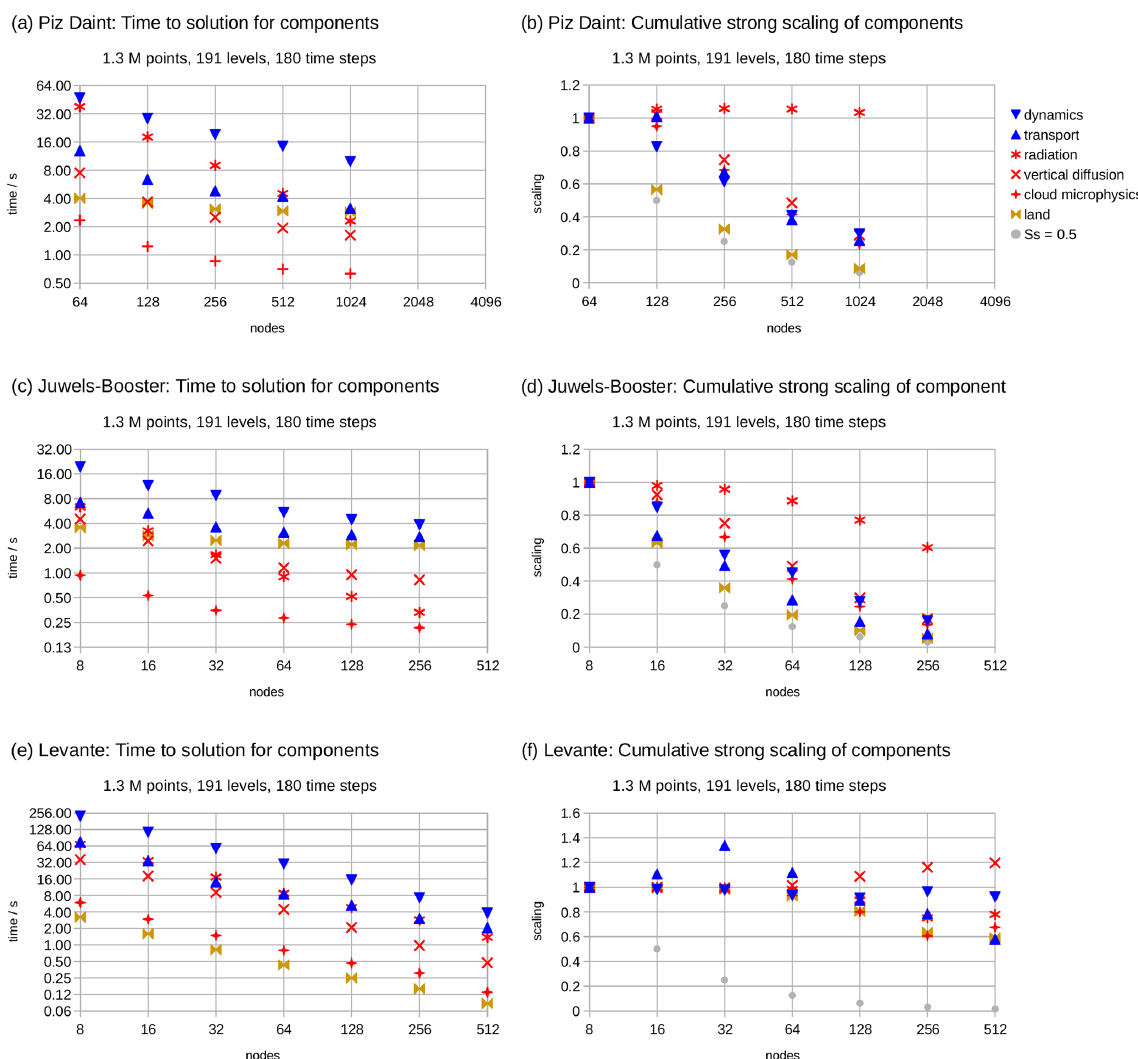
Figure 6. Time to solution (a, c, e) and cumulative strong scaling S s , cum (b, d, f) for Piz Daint (a, b) , JUWELS Booster (c, d) , and Levante (e, f) . The time used and the cumulative strong scaling are shown for the model components: in blue the resolved processes dynamics and transport; in red the atmospheric parameterizations for radiation, vertical diffusion, and cloud microphysics, and in brown the land physics. The scaling panels additionally shows in grey S s , cum for S s = 0 . 5 for a constant time to